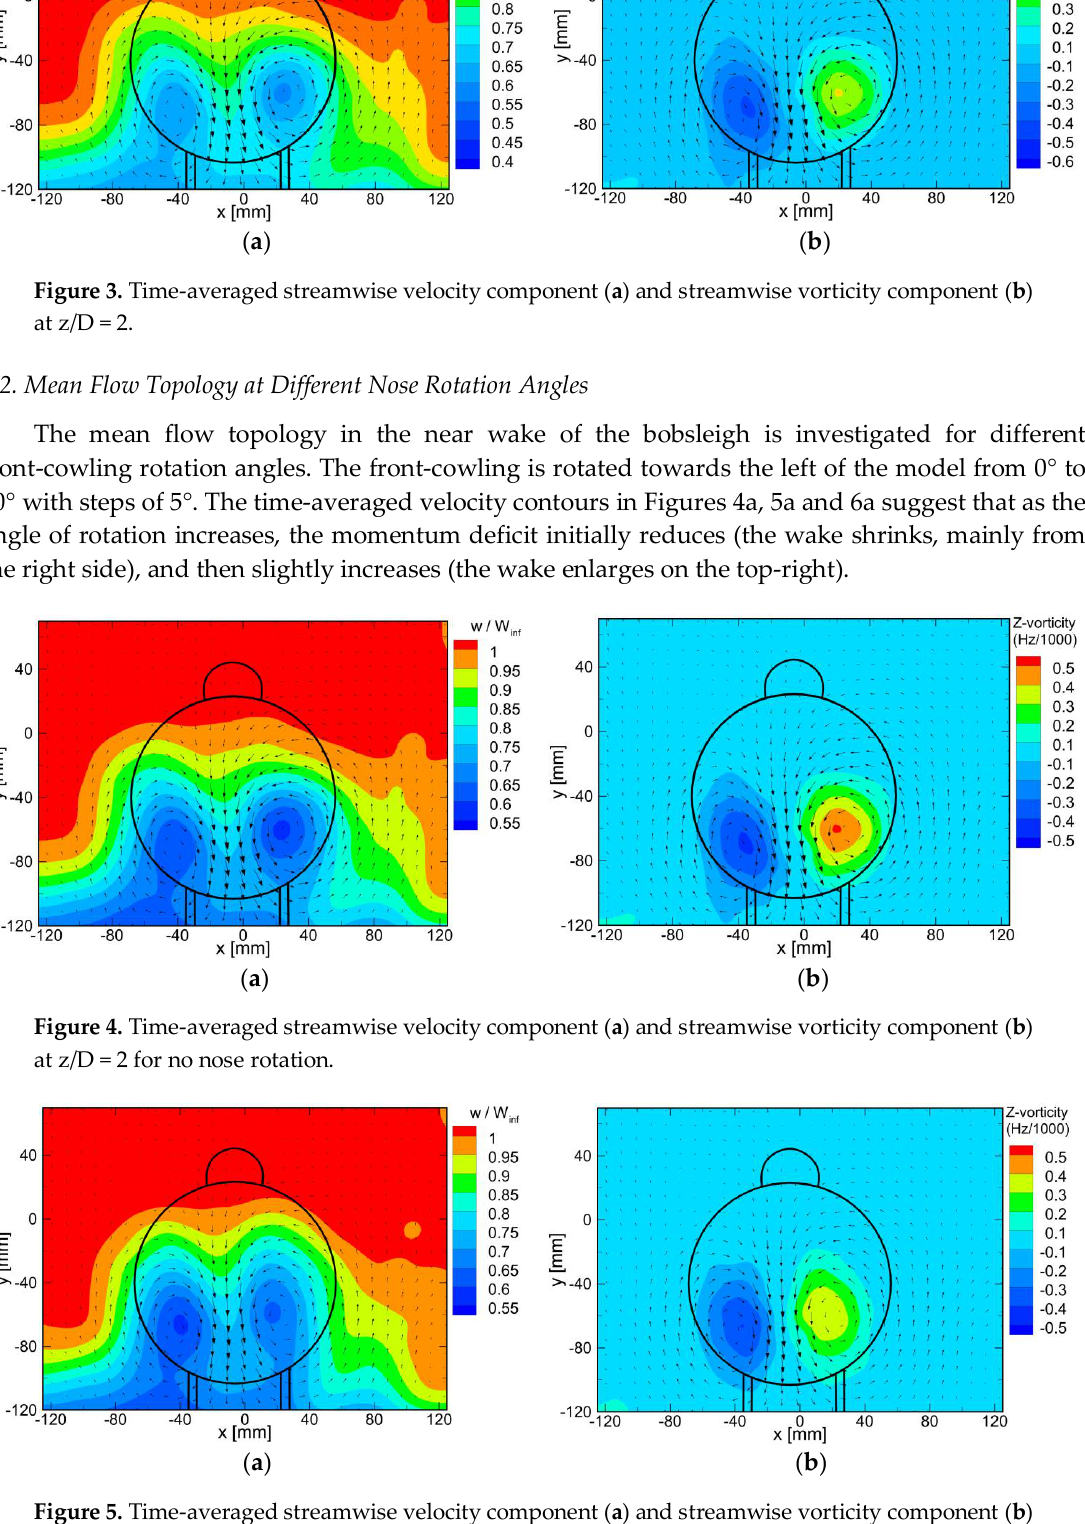
Figure 5. Time-averaged streamwise velocity component ( a ) and streamwise vorticity component ( b ) at z/D = 2 for nose rotation of